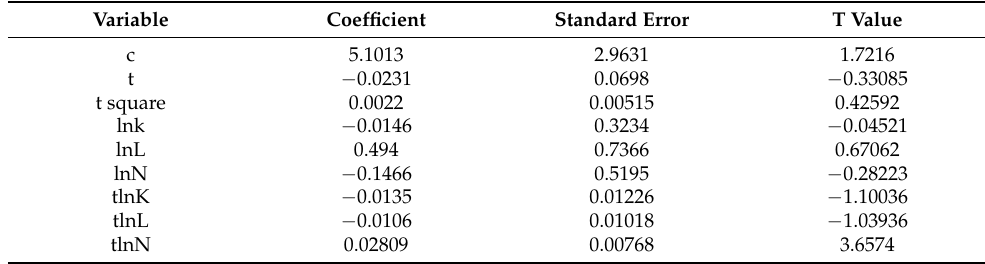
Table 2. Estimation results of production function